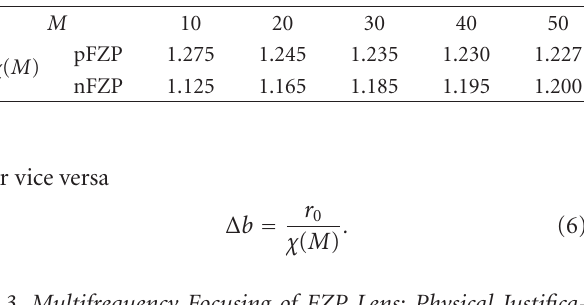
Table 1: Values of χ ( M ) for M ≤ 50.